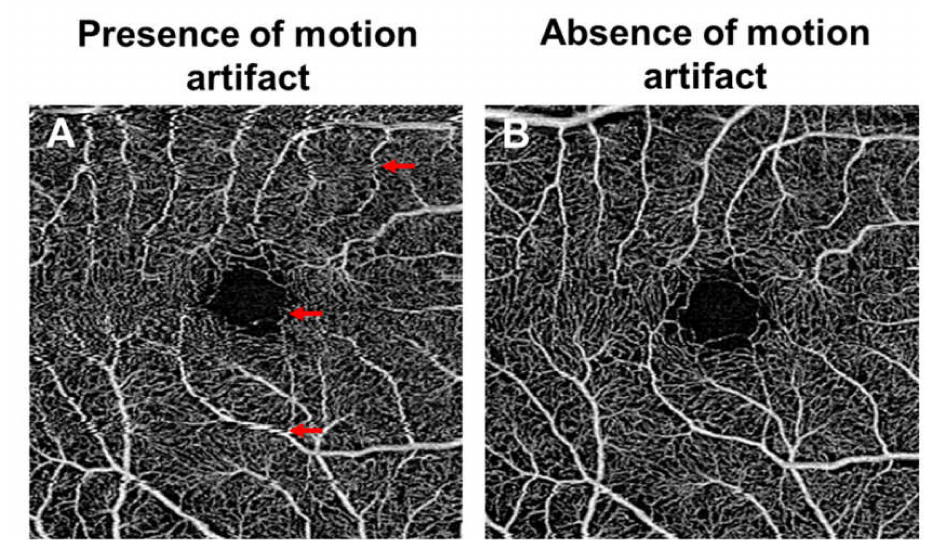
Figure 9. Optical coherence tomography angiography (OCTA; 3 × 3 mm area) of the superficial vascular plexus, showing the presence of motion artifact in the first scan ( A ) and the absence of motion artifact when a second scan was taken ( B ). Eye motion leads to discontinuities in the OCTA image (red arrows) and potentially a ff ects the quantitative